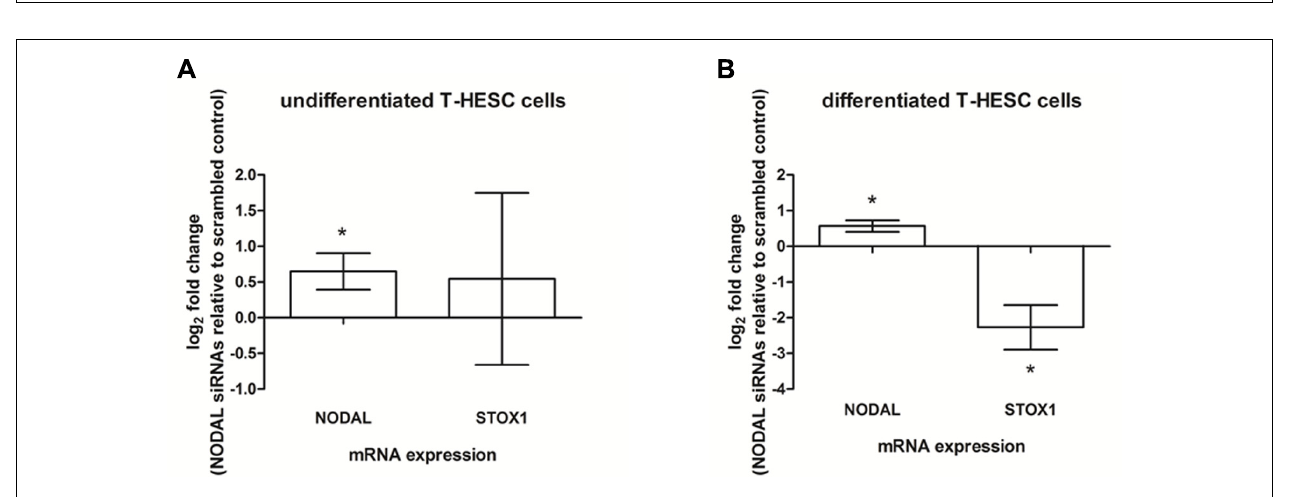
extravillous trophoblast cells [positive for both Nodal (green) and cytokeratin 7 (red), arrowheads] and decidual stromal cells [positive for Nodal (green), negative for cytokeratin 7 (red), arrows].